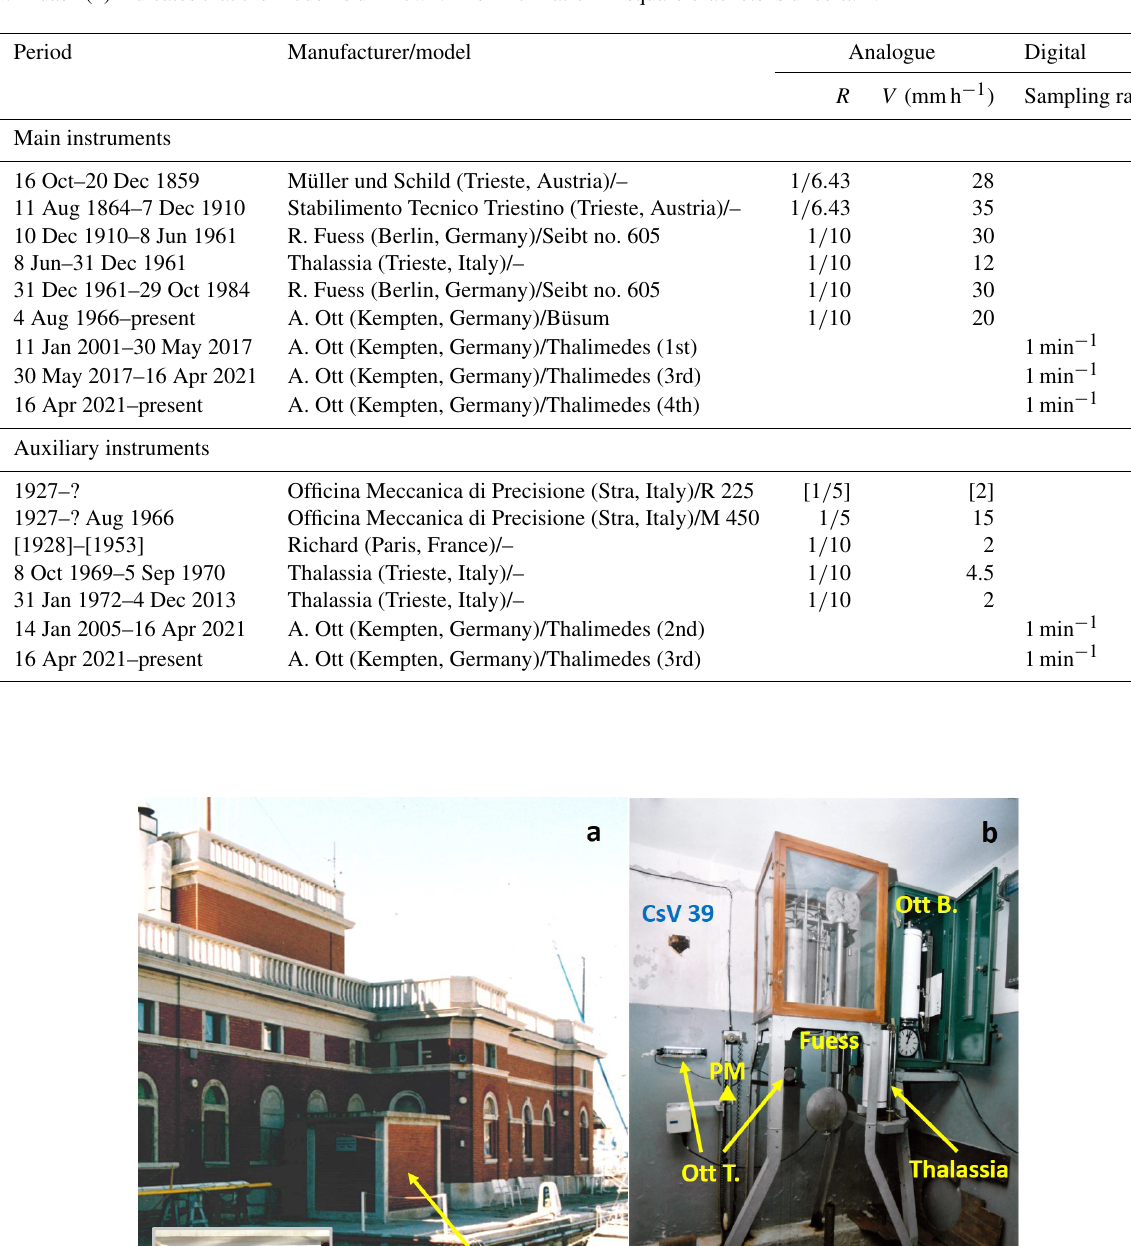
Table 1. Instruments used in the tide-gauge station and sources of their technical characteristics. R is the reduction ratio; V is the paper speed. A dash (–) indicates that the model is unknown. The information in square brackets is uncertain.